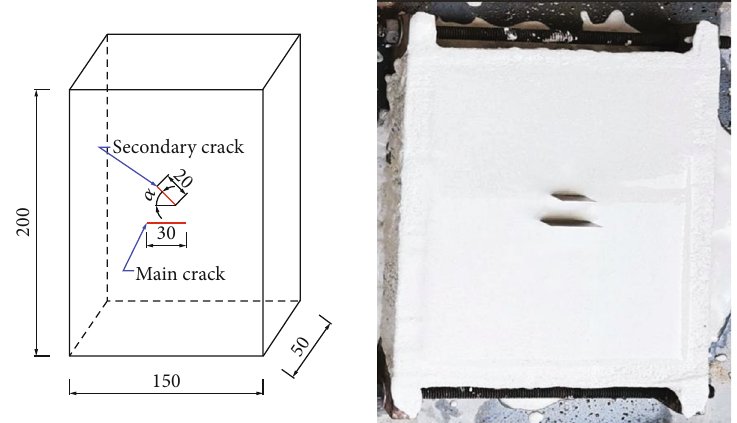
Figure 1: Model and production diagram of a group A specimen (in units of mm).